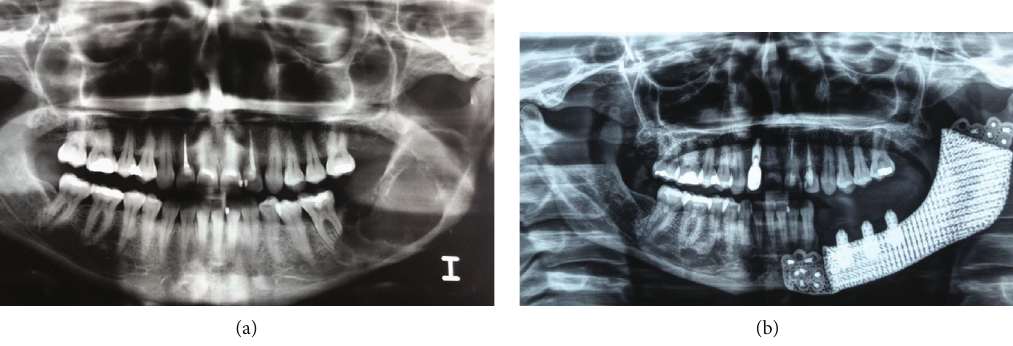
Figure 2: Preoperative (a) and postoperative (b) radiographs.